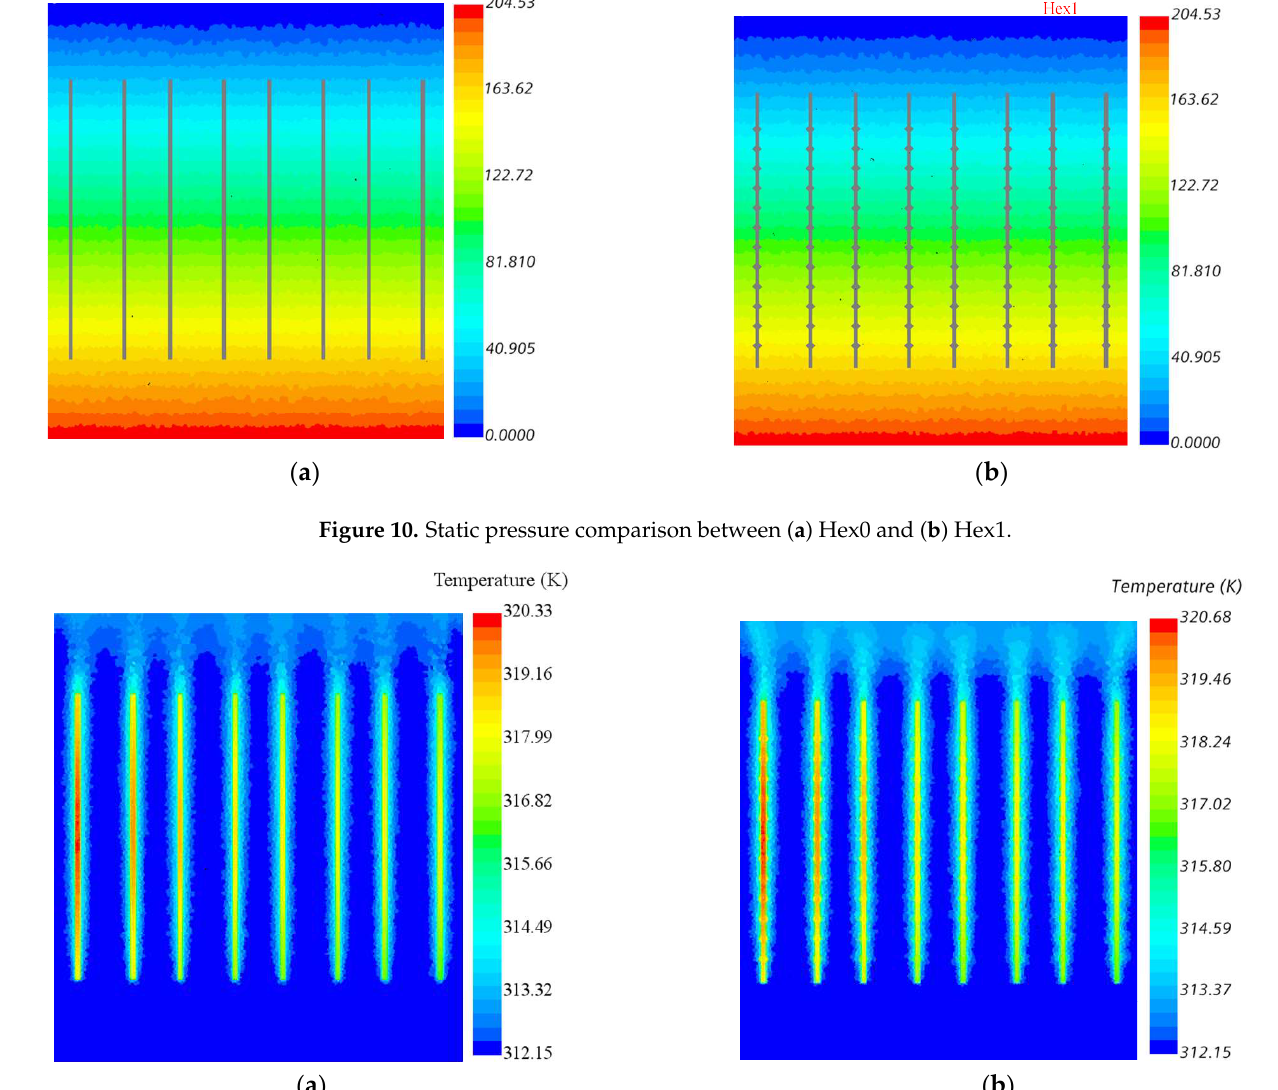
Figure 10. Static pressure comparison between ( a ) Hex0 and ( b ) Hex1.